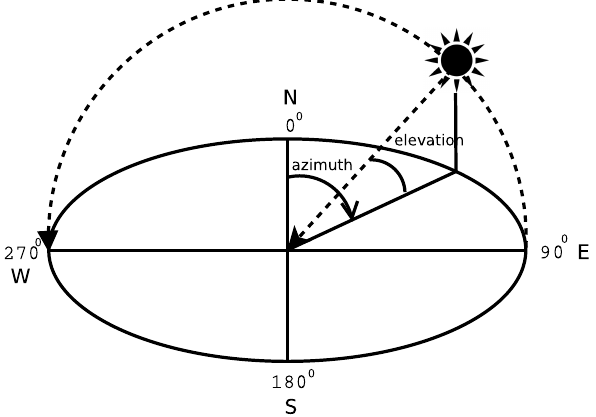
Figure 1. The Sun Position Diagram.